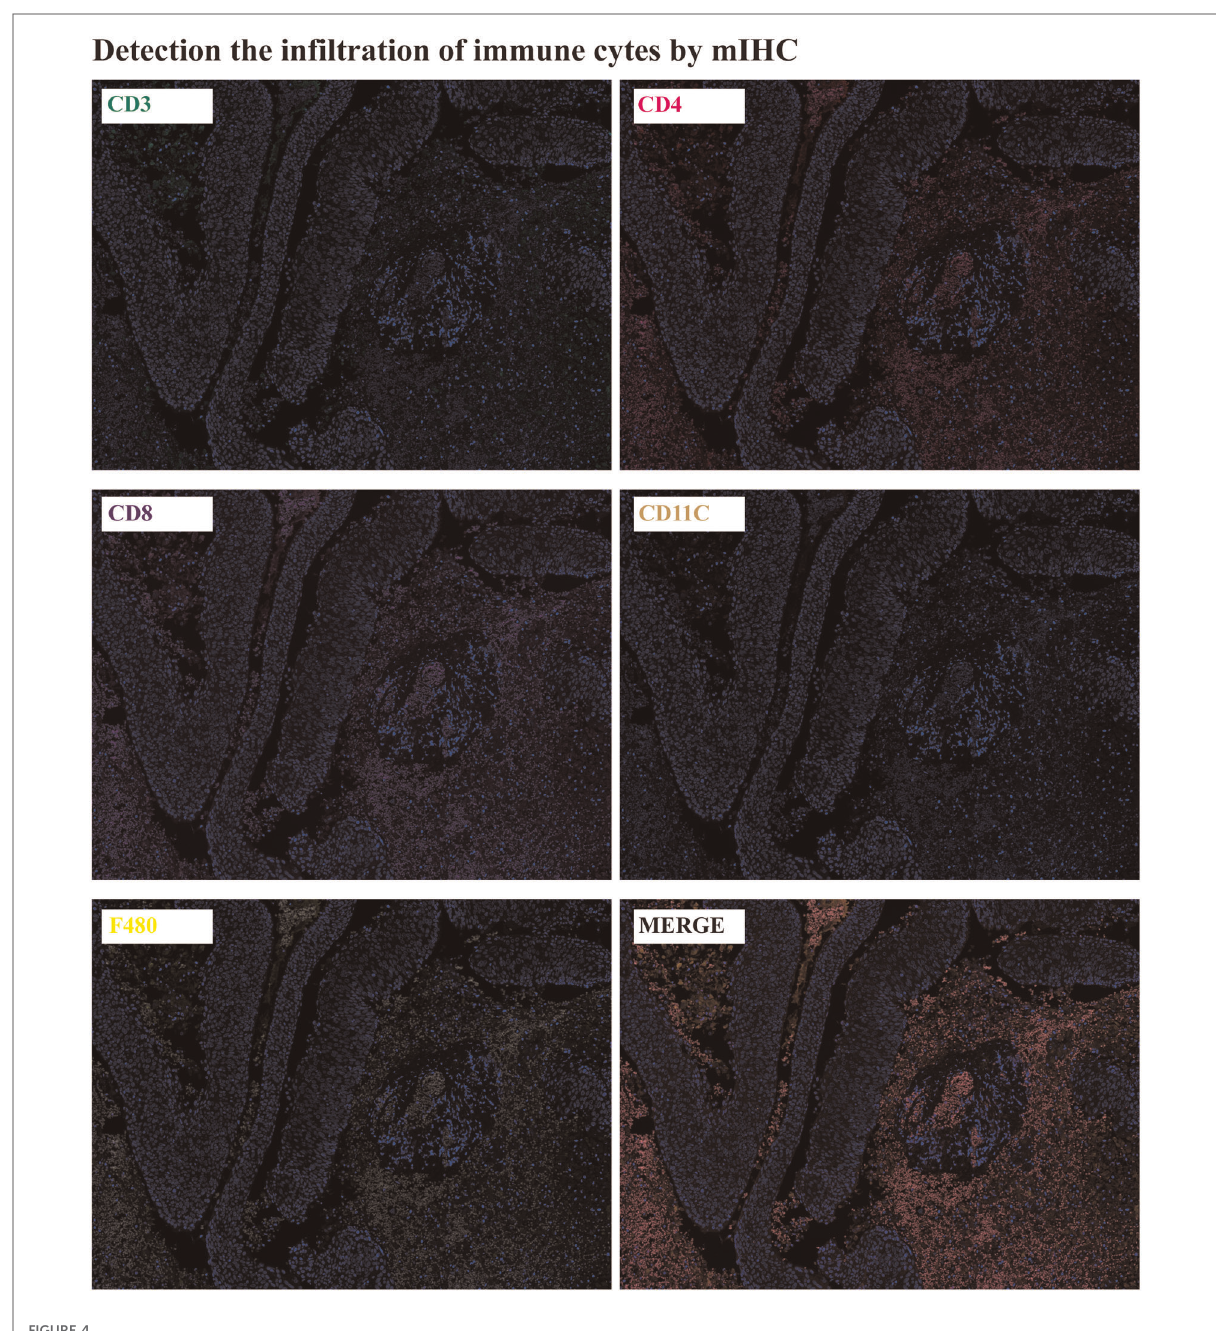
FIGURE 4 Detection the immune cells in fi ltration by